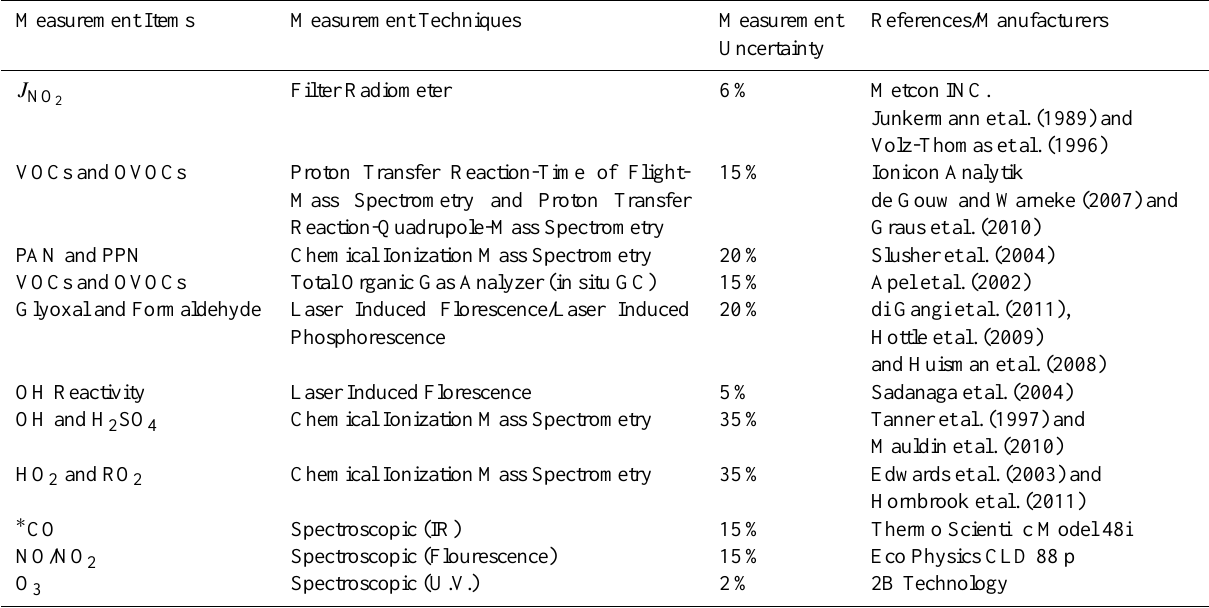
Table 1. A summary of the instrument suite for BEACHON-ROCS